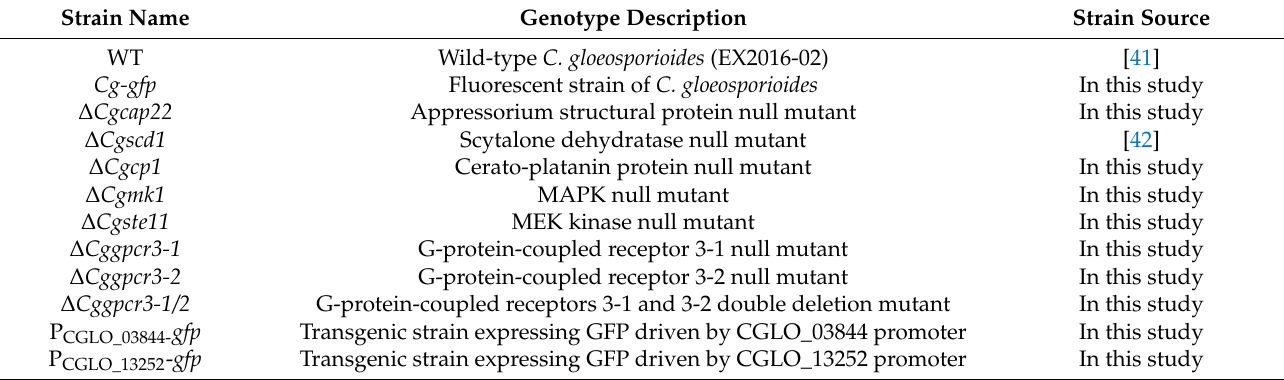
Table 1. Fungal strains used in this